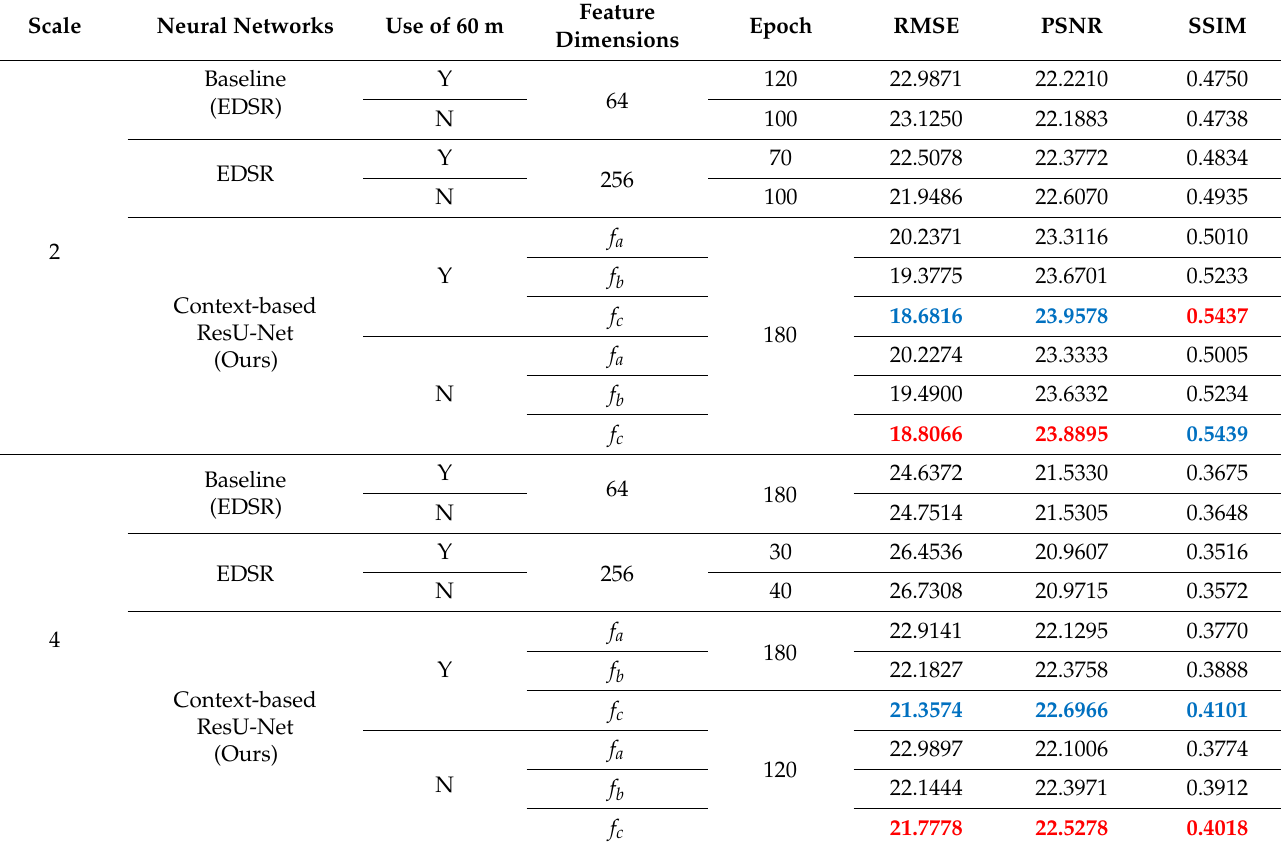
Table 3. Quality evaluation results with set parameters for Daejeon City. Blue indicates the best results, and red indicates the second